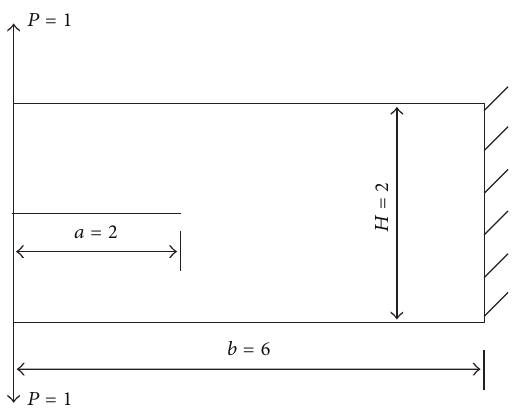
Figure 24: Double cantilever beam with an edge crack.